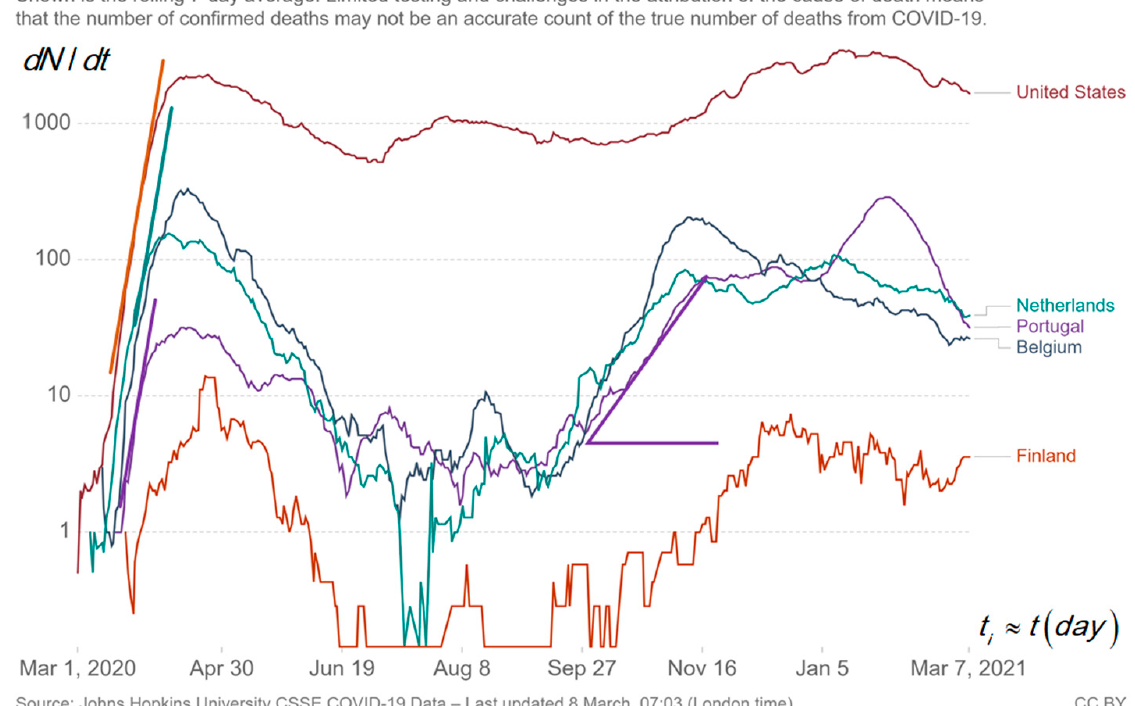
Figure 3. The log–lin epidemic curve for new deaths in USA, Portugal, Belgium, the Netherlands and Finland [1]. The low numbers for Finland are noisier, and zero cannot be shown on a logarithmic scale. The peaks in the middle are not observable in a lin–lin plot because it is about a factor of 30 lower than the highest peak. The slopes are indications for the analysis in τ grow , τ recov and n = τ recov / τ grow .